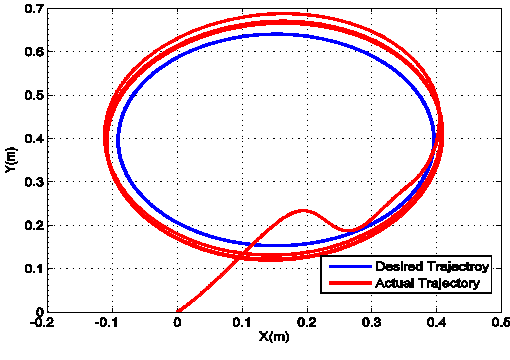
Fig. 8. MRSE robotic arm trajectory in XY plane.